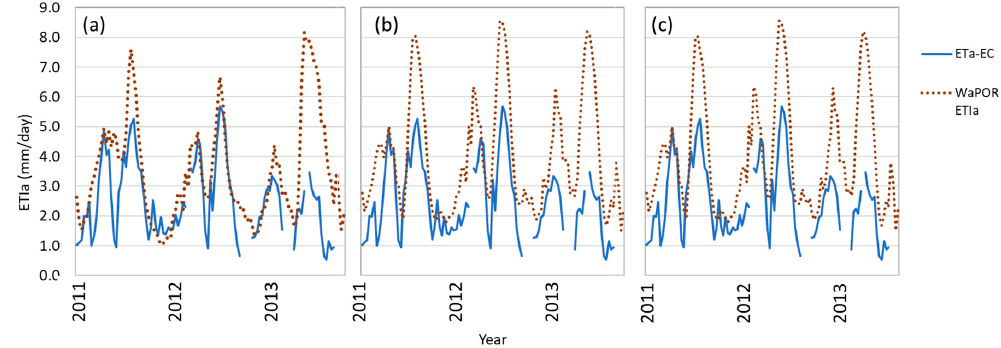
Figure 9. WaPOR dekadal ( a ) L3, ( b ) L2 and ( c ) L1 ETIa (mm/day) compared to in-situ dekadal ETa